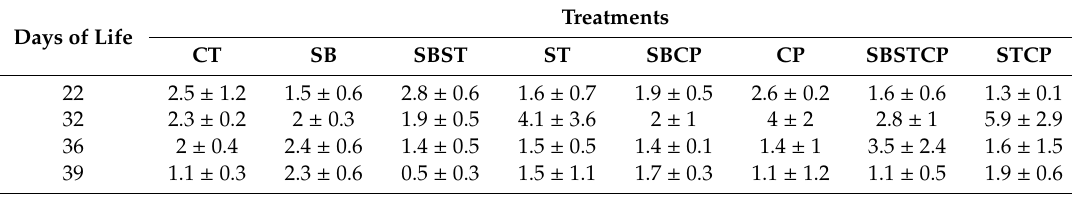
Table 1. Bursa morphometric index of broilers treated with the synbiotic mix and inoculated with Salmonella typhimurium and Clostridium perfringens.